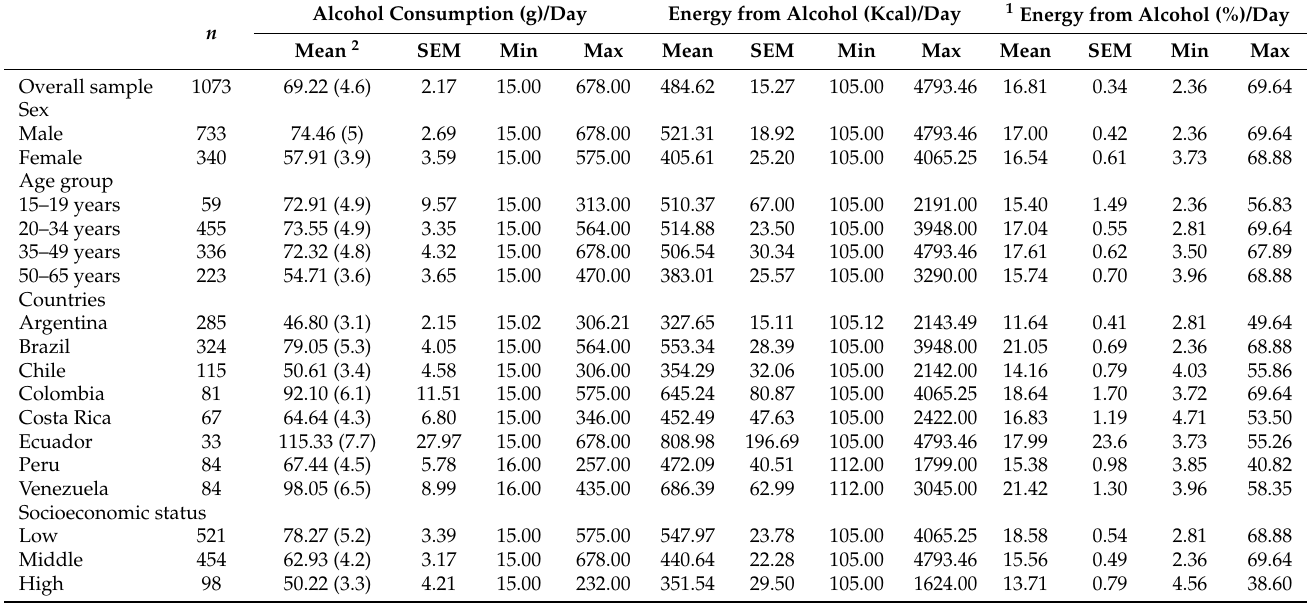
Table 1. Alcohol-consumption parameters according to the sociodemographic characteristics of alcohol